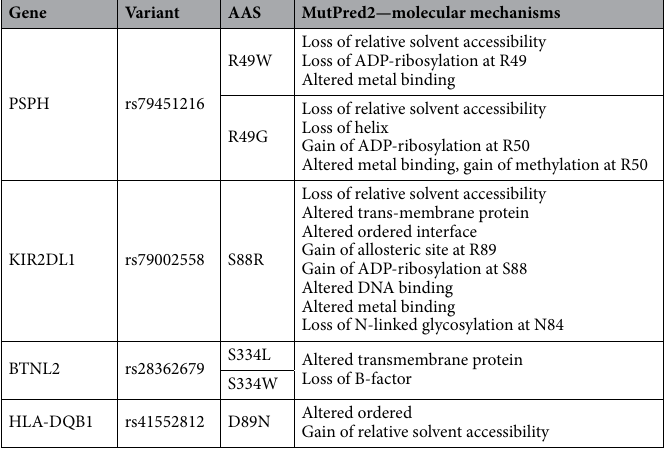
Table 2. Variants detected as frequent in the Serbian population sample that MutPred2 44 predicted as affecting protein